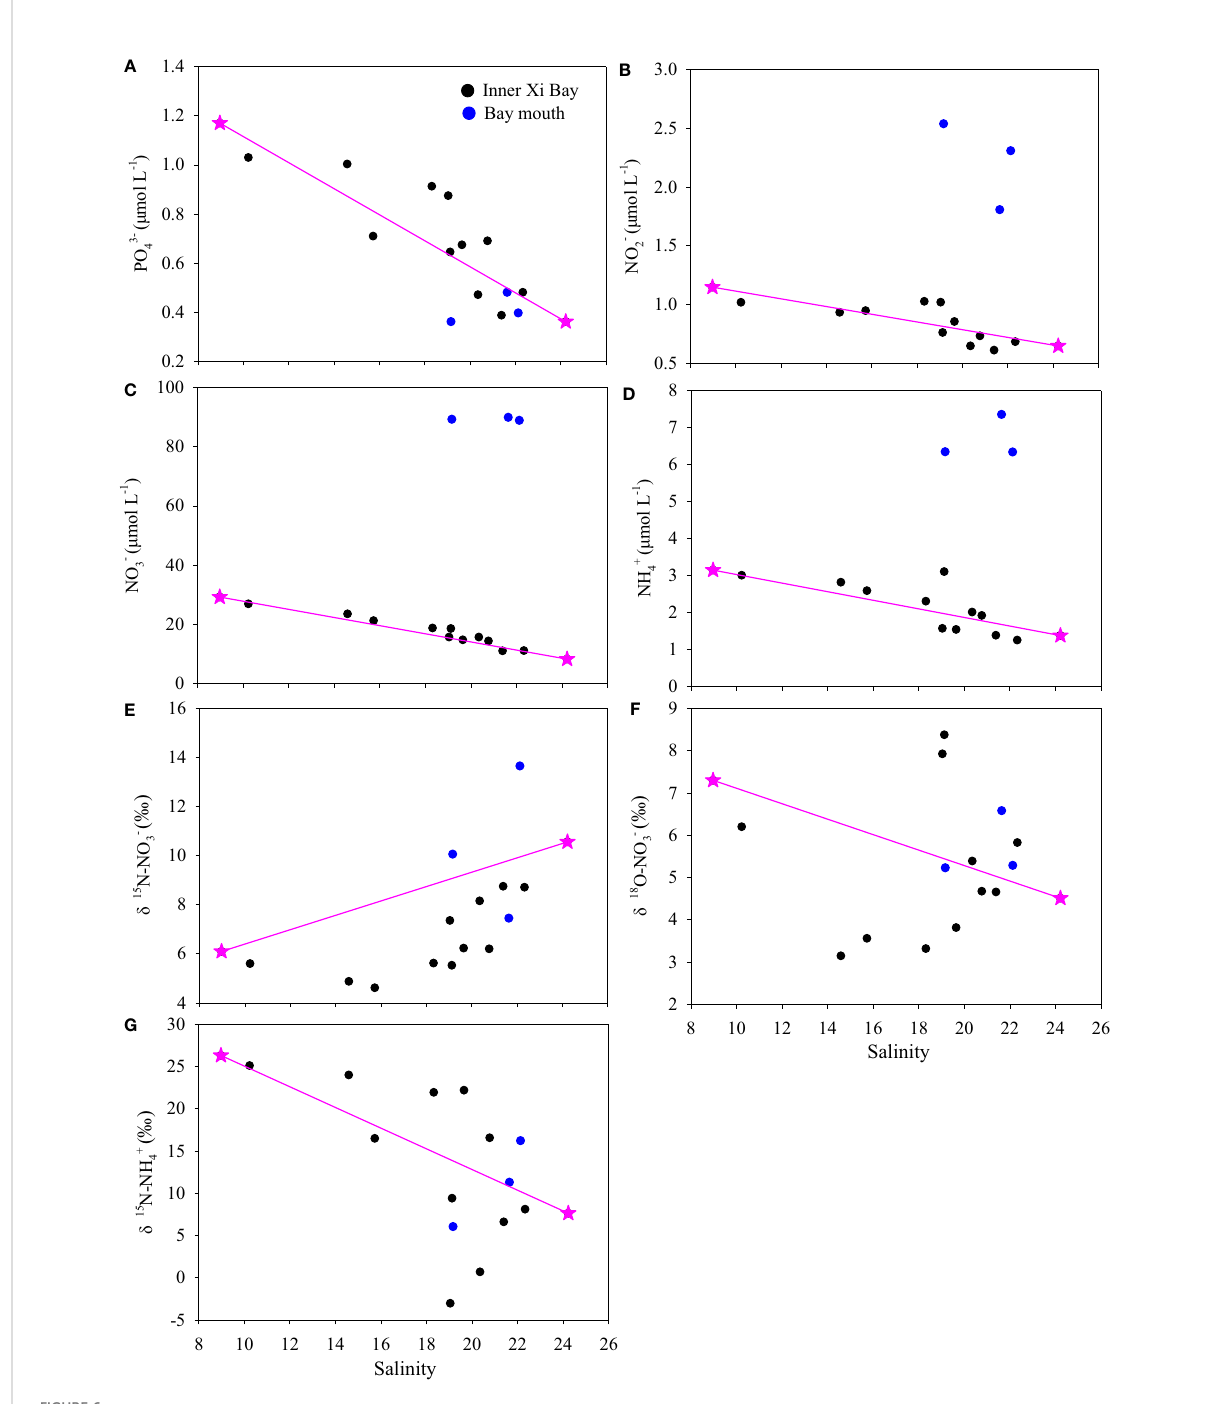
FIGURE 6 Distribution of nutrients and isotopic values against salinity in Xi Bay. The black dots are the samples excluding the stations in the bay mouth of Xi Bay; the blue dots are the samples in the bay mouth. The pink lines indicate the mixing line. The inner bay includes the upper bay and lower bay (stations X1 to X12); the bay mouth includes stations X13 to X15. (A) , PO 43- (B) , NO 2- (C) NO 3- (D) NH 4+ (E) , d 15N-NO 3- (F) , d 18O-NO 3- (G) , d 15N-NH